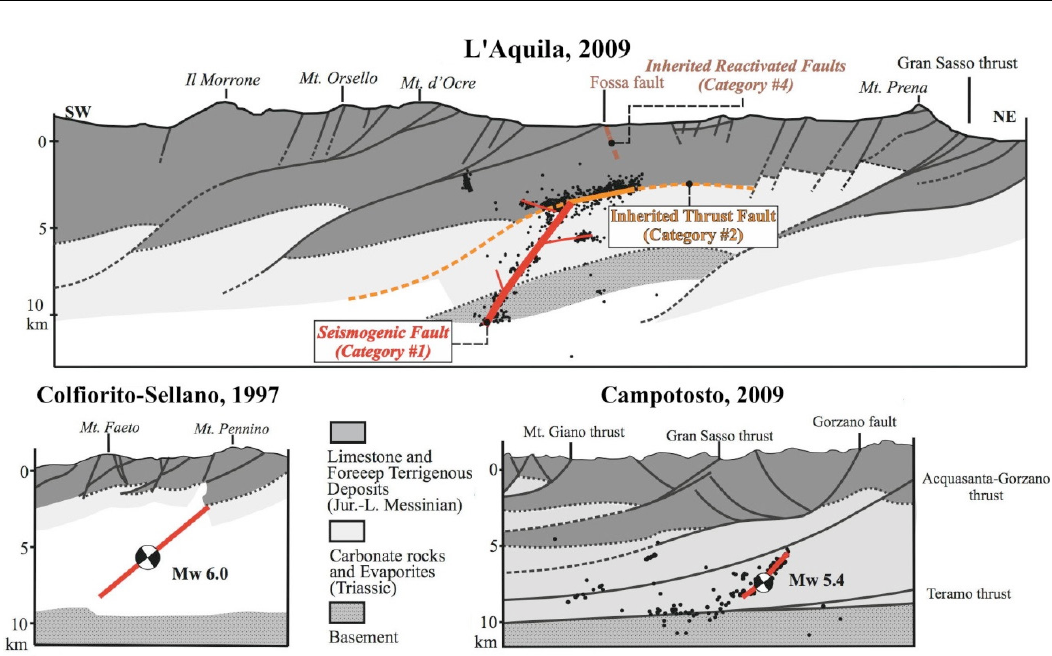
Figure 3 . Geological sections across the causative faults of the 6 April 2009, L’Aquila, 26 September 1997, Colfiorito (based on data from Chiaraluce et al. [2005]), and 9 April 2009, Campotosto (based on data from Bigi et al. [2012]) earthquakes. The seismogenic sources are shown by a red line; black dots show aftershock locations. The sections illustrate the vertical confinement of the seismogenic sources within pre-existing thrusts, locally illuminated by minor aftershocks (from Bonini et al. [2014], modified).